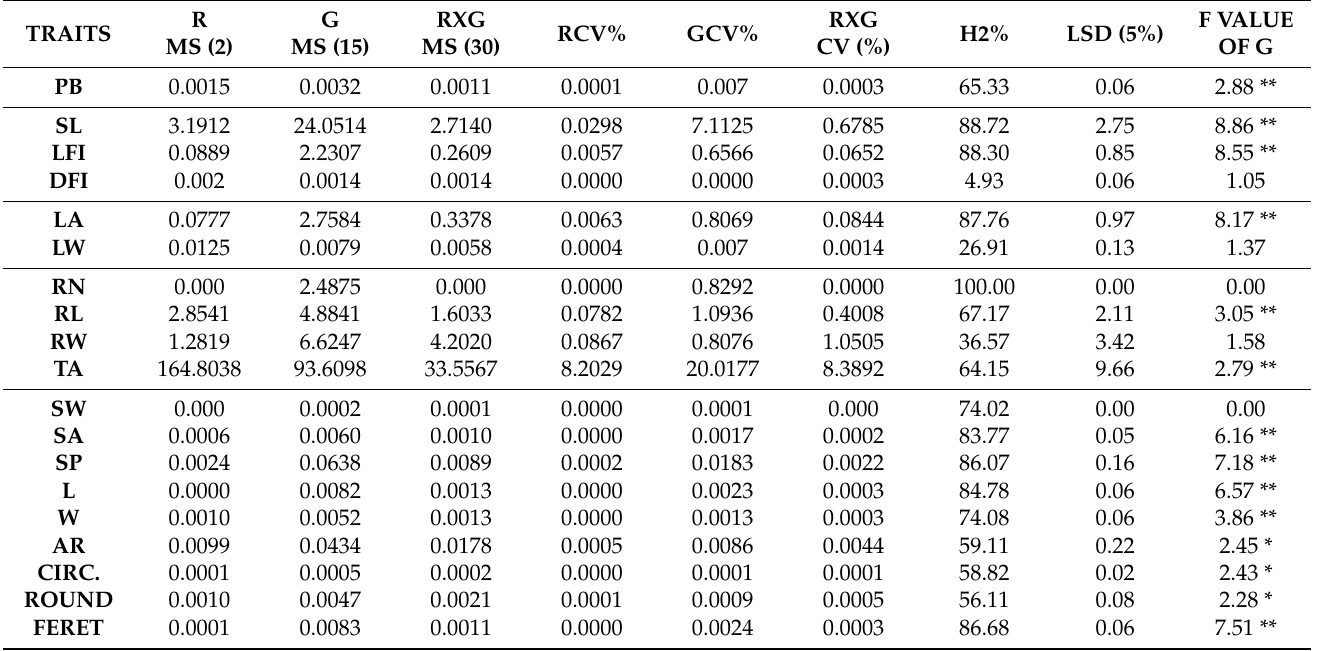
Table 4. Estimation of genotypic coefficient variance, heritability analysis of morphometric traits of the 16 T. aestivum genotypes